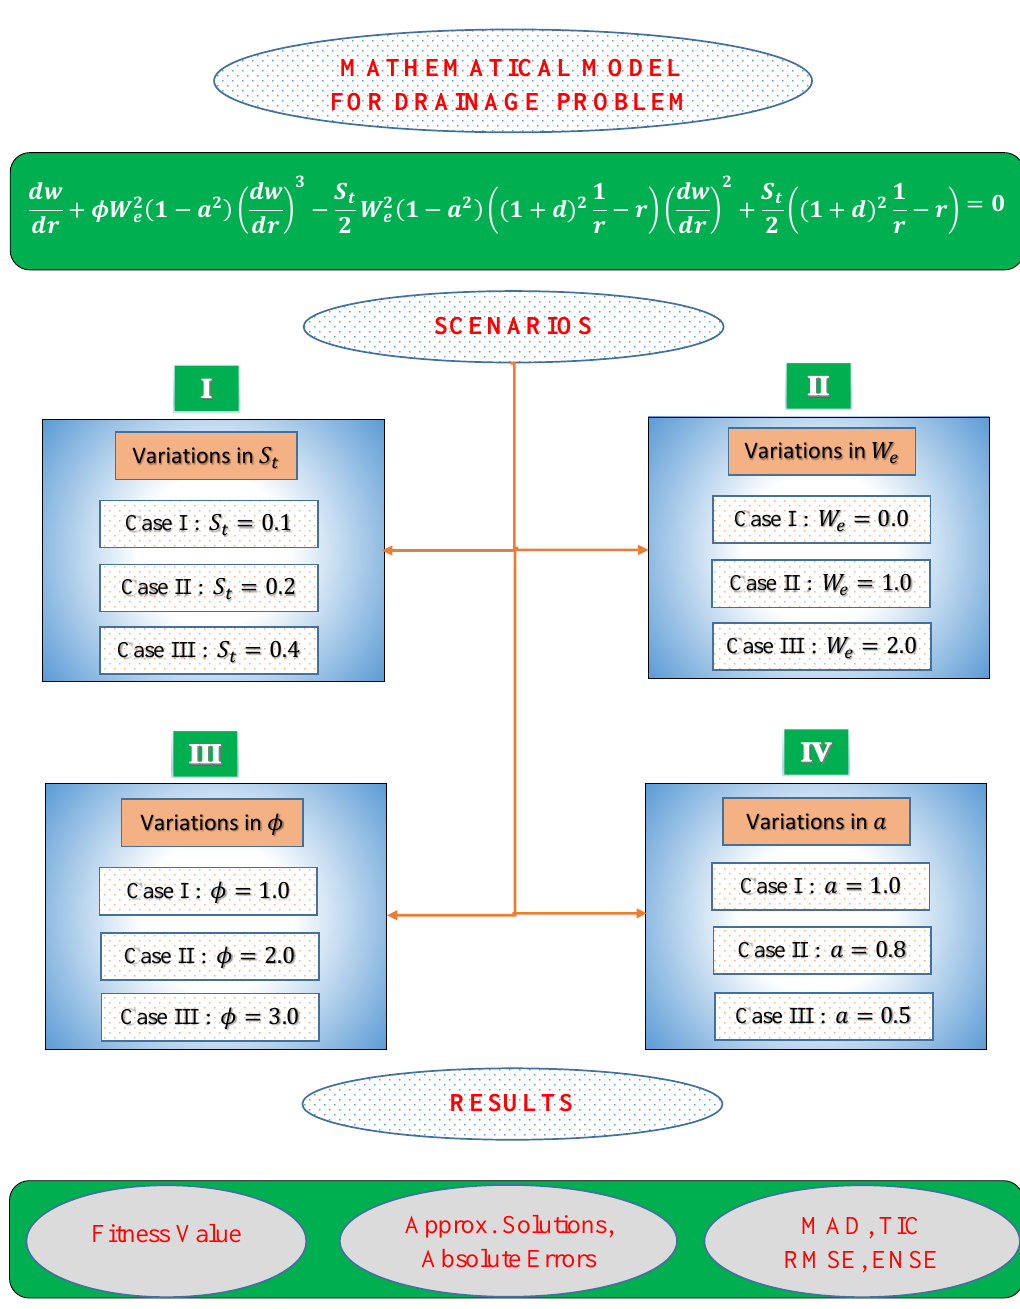
Figure 4. Graphical overview of the problem considered in this